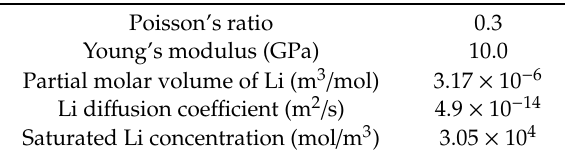
Table 3. Material parameters of graphite particles